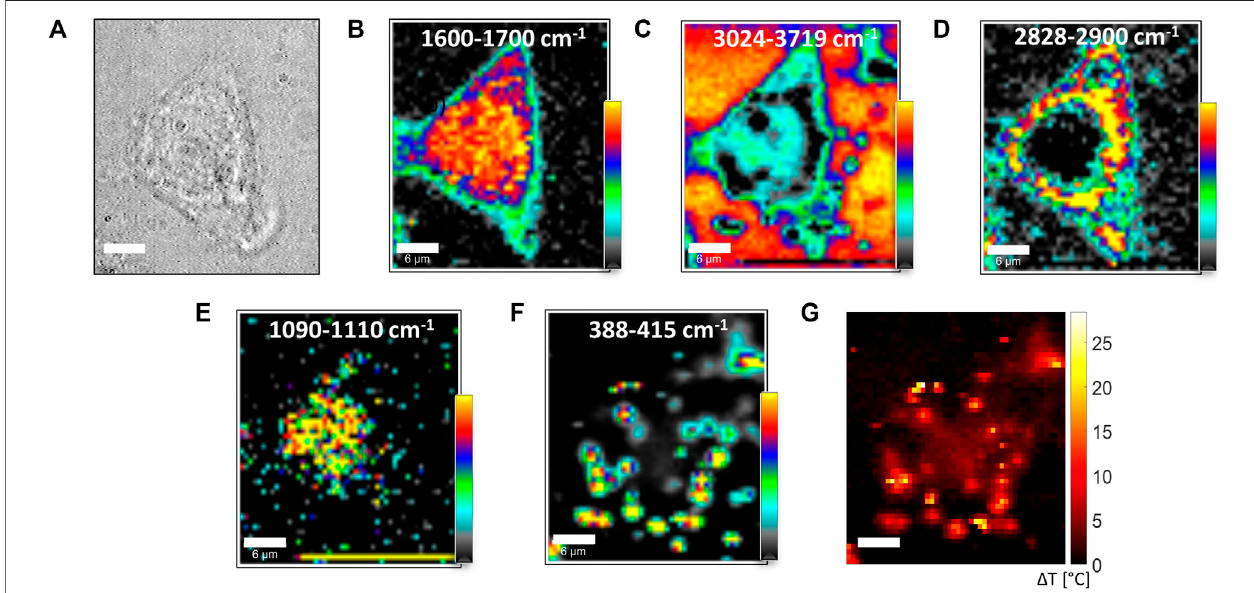
FIGURE7|(A) Bright- fi eldimageofanMCF7cellexposedto2D-MoS 2 . (B – F) Integratedintensityofselectedbandsobtainedinarasterscanningofa30- μ m×30- μ m region with a 600-nm step. P τ were 30 mW and 2 s, respectively, so the whole image was acquired in ~ 83 min. Confocal Raman section was acquired in a R and plane,cuttingthroughthenucleus,at~5 μ mfromtheglassinterface.Thelabelsineachpanelcorrespondtothespectralregionsselectedforbandintensityintegrations. Color scales are relative scales, with the darker and brighter colors corresponding to the lowest and highest integrated intensity values, respectively. Such maps provideinformationonthespatialdistributionofproteins(panelB),water(panelC),lipids(panelD)DNA(panelE),and2D-MoS 2 (panelF). (G) Temperatureincreaseofthe analyzed cell obtained starting from the estimation of the R ratio in the scanned region.